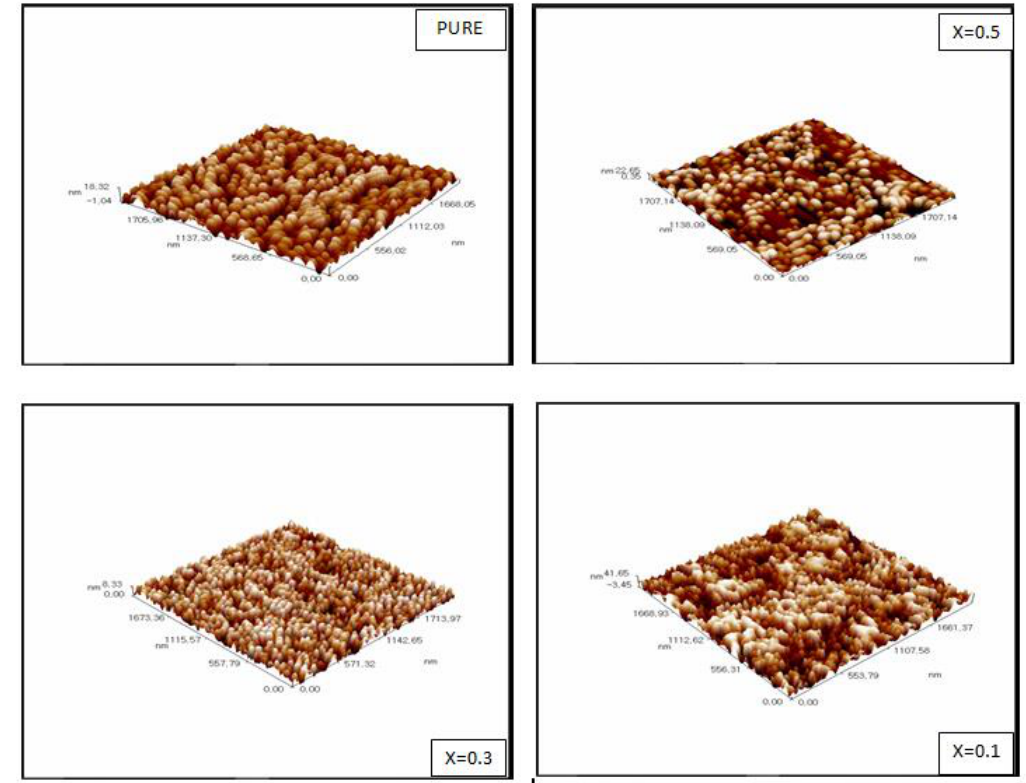
O ) (TiO ) films at RT with different TiO 2 5 1-x 2 x